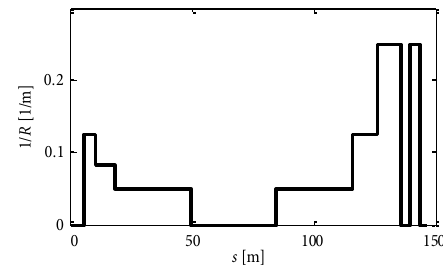
Fig. 15. Required curvature of the track